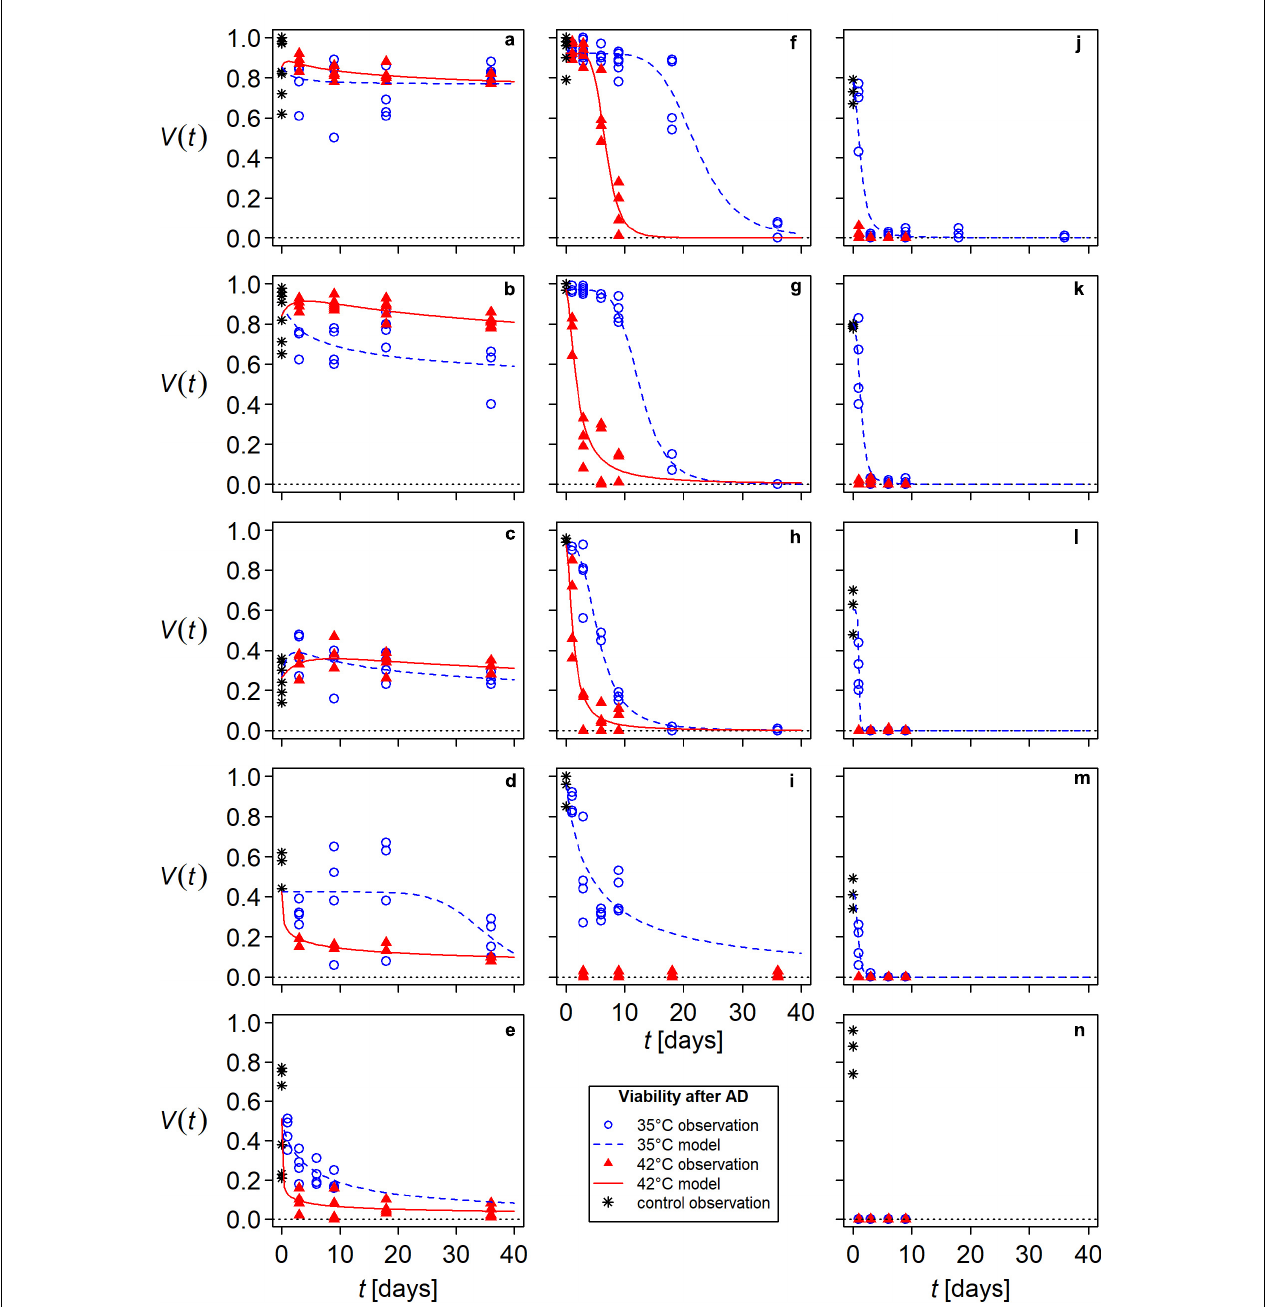
FIGURE 2 | Modeled seed viability, V , of flowering wild plant species and tomato during anaerobic digestion (AD) in lab-scale reactors at 35 ◦ C (blue, dashed lines) and 42 ◦ C (red, solid lines). Symbols present observations, each containing a minimum of 100 seeds: asterisks for untreated controls, blue open circles for AD at 35 ◦ C and red filled triangles for AD at 42 ◦ C. (a) Melilotus officinalis , (b) Melilotus albus , (c) Malva sylvestris , (d) Malva alcea – 2 years , (e) Malva alcea – 1 year , (f) Chenopodium album , (g) tomato – PIERRE, (h) tomato – PAPRIKA, (i) Abutilon theophrasti – 1 year , (j) Abutilon theophrasti – 7 years , (k) Daucus carota , (l) Cichorium intybus , (m) Echium vulgare , (n) Verbascum thapsus . For better comparability, panels were arranged according to the species’ viability after 36 days of exposure to